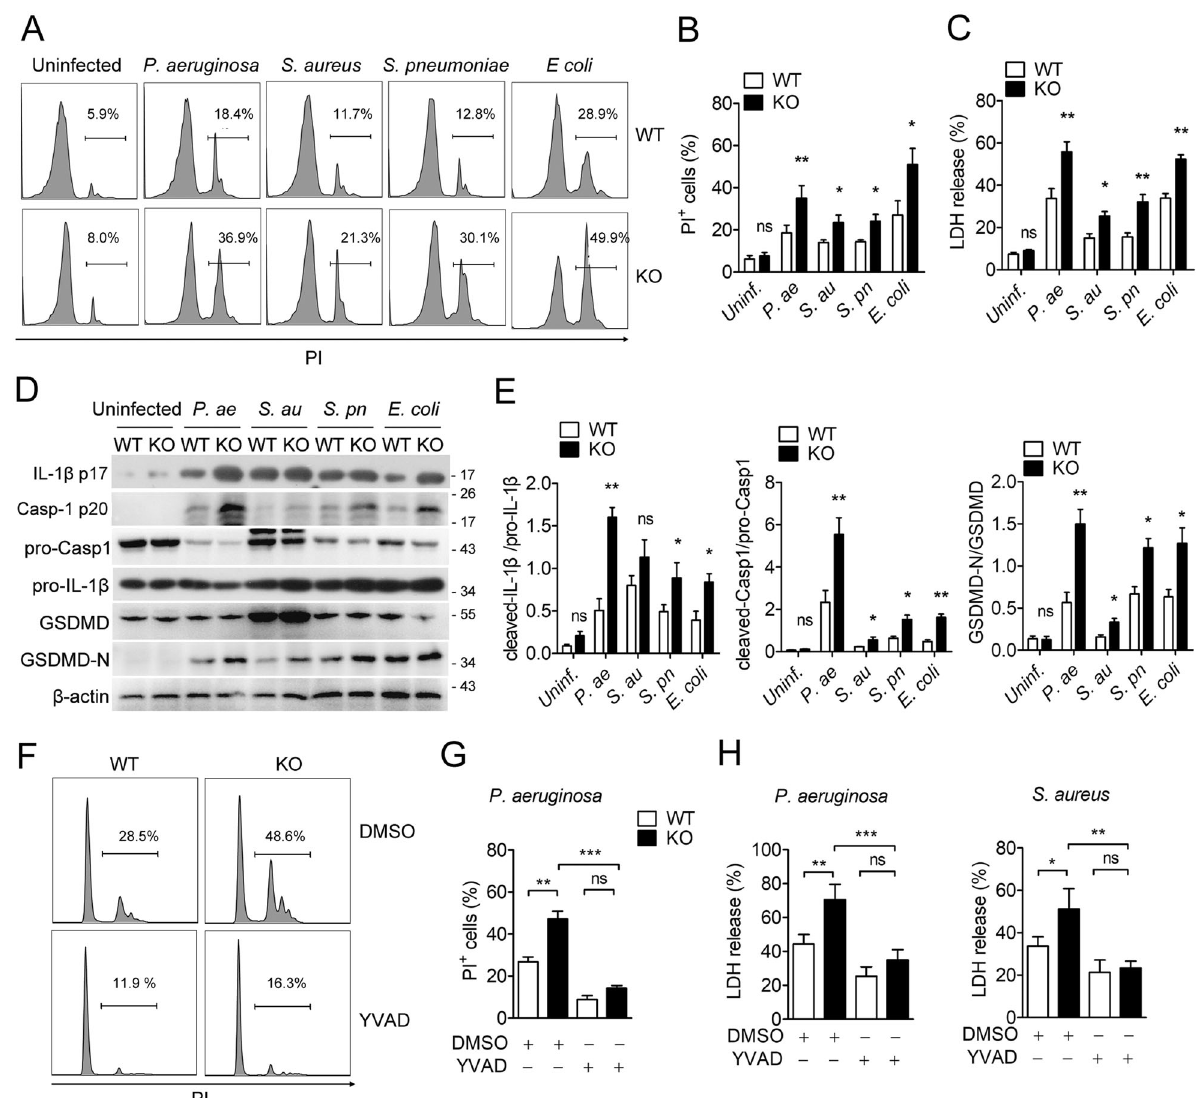
Fig. 1 TREM2 inhibits pyogenic bacteria-induced macrophage pyroptosis. A – E BMDMs isolated from wildtype (WT) or TREM2 knockout (KO) B6 mice were stimulated with LPS (100 ng/ml) for 12 h, and then infected with Pseudomonas aeruginosa , Staphylococcus aureus , Streptococcus pneumoniae , Escherichia coli at an MOI of 10 for 3 h. F – H LPS primed WT or KO BMDMs were pretreated with vehicle control (DMSO) or Ac-YVAD-CMK (40 μ M) for 45 min, followed by Pseudomonas aeruginosa or Staphylococcus aureus infection. A , F Cell death was analyzed by fl ow cytometry with PI staining and representative fi gures were shown. B , G Quanti fi cation of dead cells (PI + ). D Protein levels of pro-Caspase-1, cleaved-Caspase-1, pro-IL-1 β , cleaved-IL-1 β , and GSDMD in cell lysates or supernatants of each group were detected by western blot. E Relative densities of indicated blots. C , H Cytotoxicity was detected by LDH release assay. Data are representative of at least three experiments. Error bars represent the mean ± SEM. * P < 0.05; ** P < 0.01; *** P < 0.001. ns no signi fi